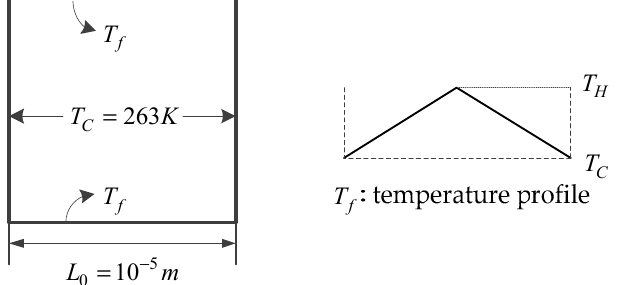
Figure 11. Numerical setup for thermally driven cavity flow.